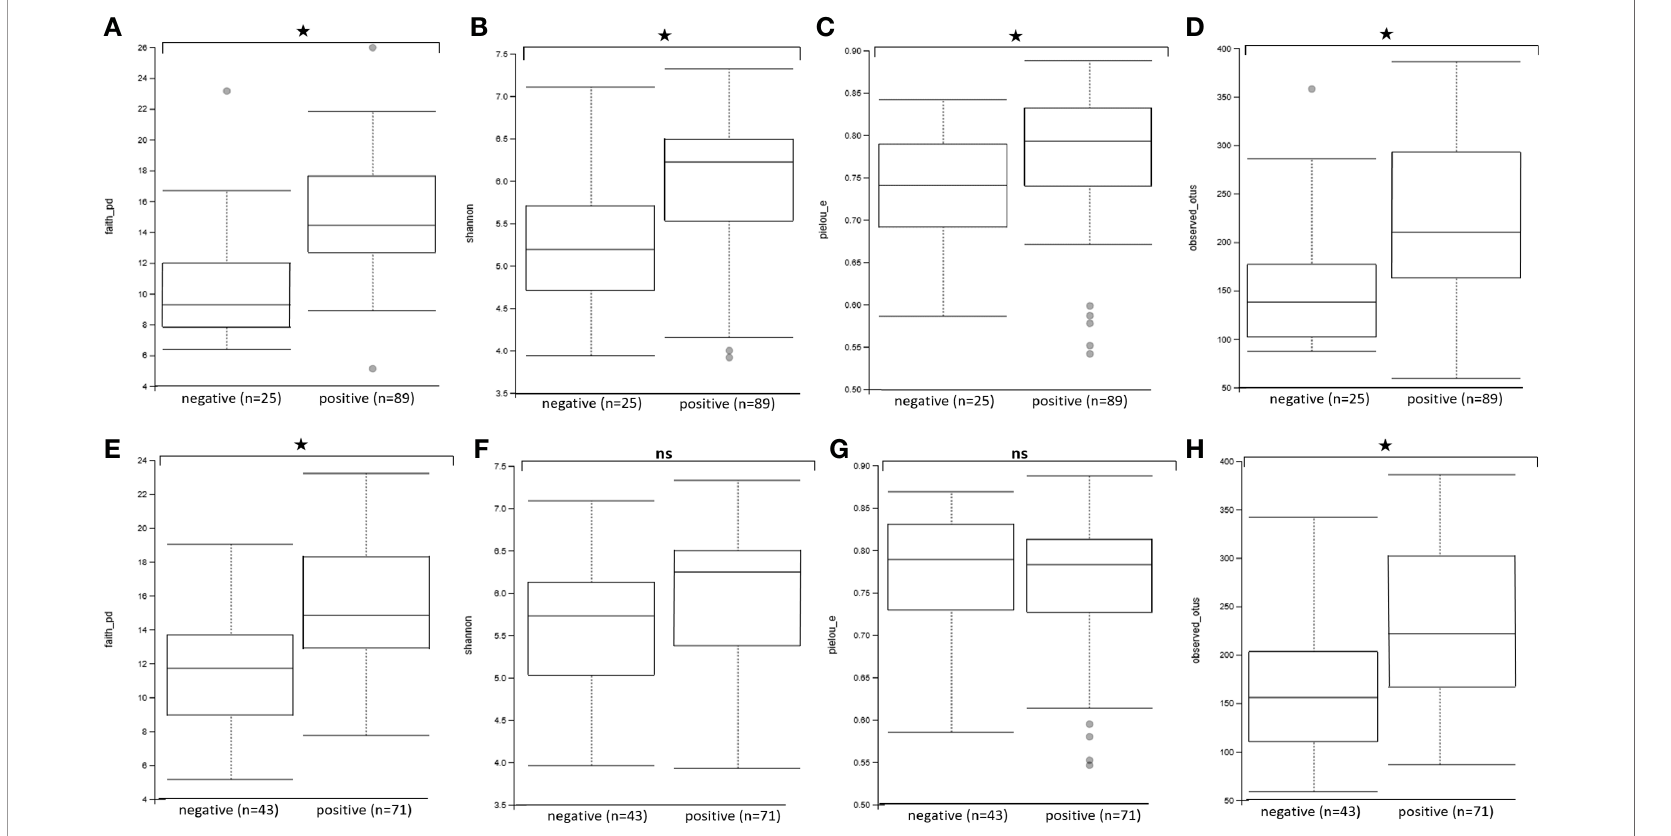
FIGURE 4 | Comparison of alpha diversity indices between Blastocystis -positive and Blastocystis -free groups (A – D) and Entamoeba -positive and Entamoeba -negative groups (E – H) . (A, E) Faith ’ s Phylogenetic Diversity (faith_pd). (B, F) Shannon index (shannon). (C, G) Pielou ’ s evenness index (pielou_e). (D, H) observed ASVs (observed_asvs). ns, not signi fi cant. *p <